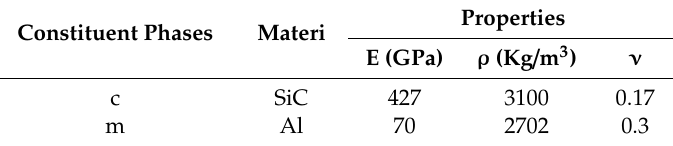
Table 3. Material properties of the BD-FG cylindrical